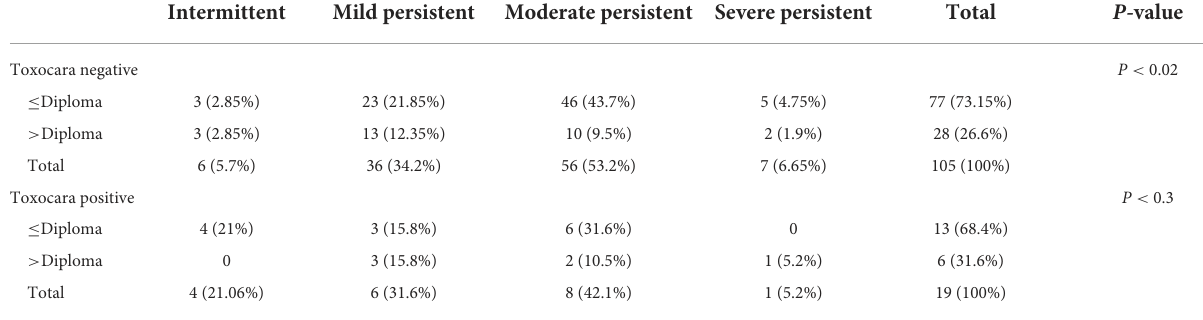
TABLE 3 Severity of asthma manifestations and education level according to the results of Toxocara